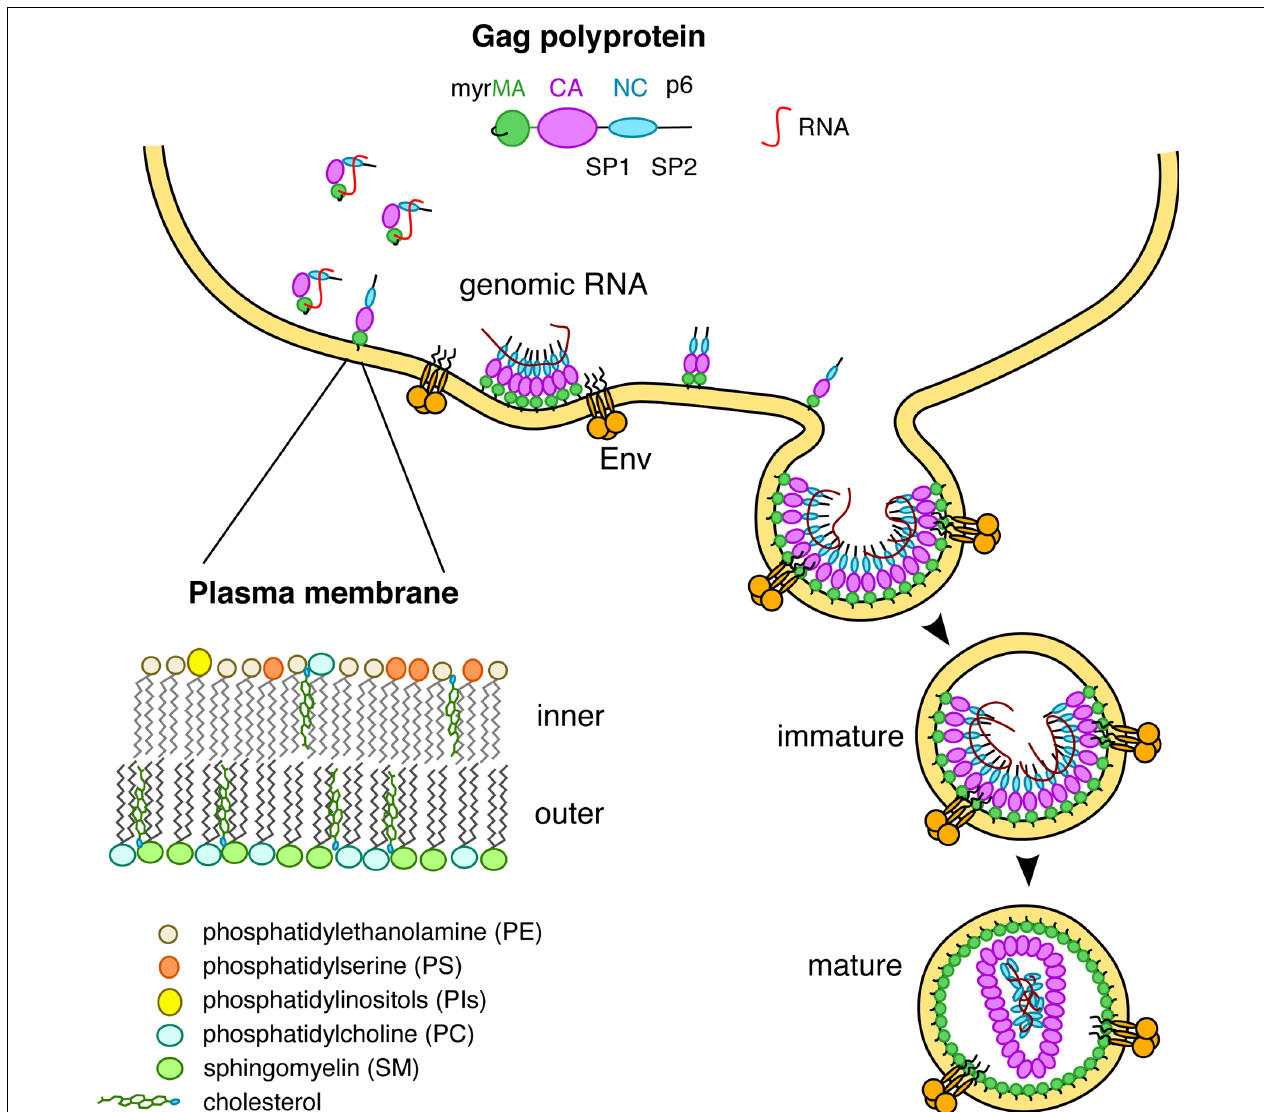
FIGURE 1 | The MA domain of Gag is involved in multiple interactions including RNA and lipids on the inner leaflet of the